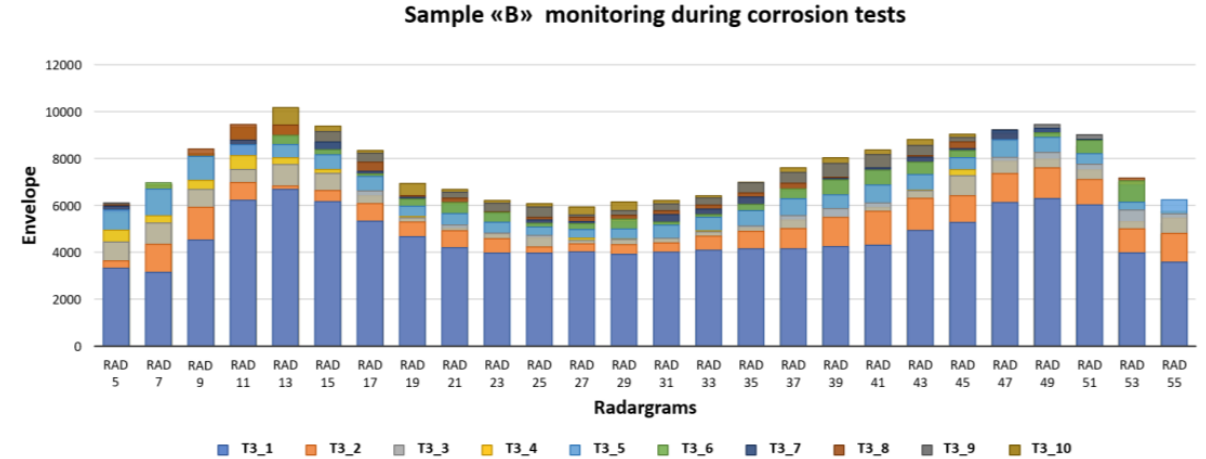
Figure 16. Envelope values along the steel rebar for sample “B” during the accelerated corrosion tests for ten days of monitoring. The investigation at T3_1 was carried out after 24 h, switching on the power supply, and subsequent surveys, every 24 h.